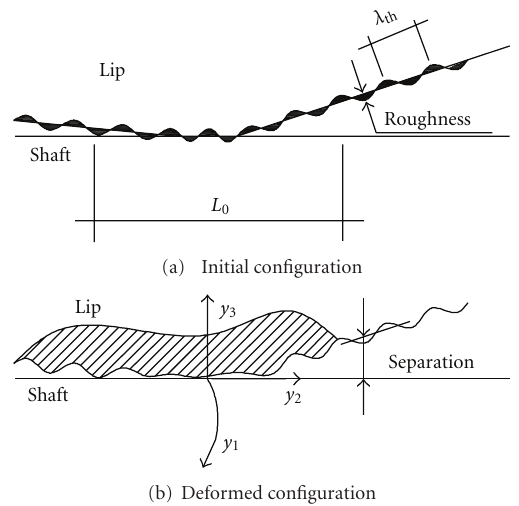
Figure 1: Contact scheme: (a) reference geometry; (b) deformed geometry obtained by solving the fluid/solid contact